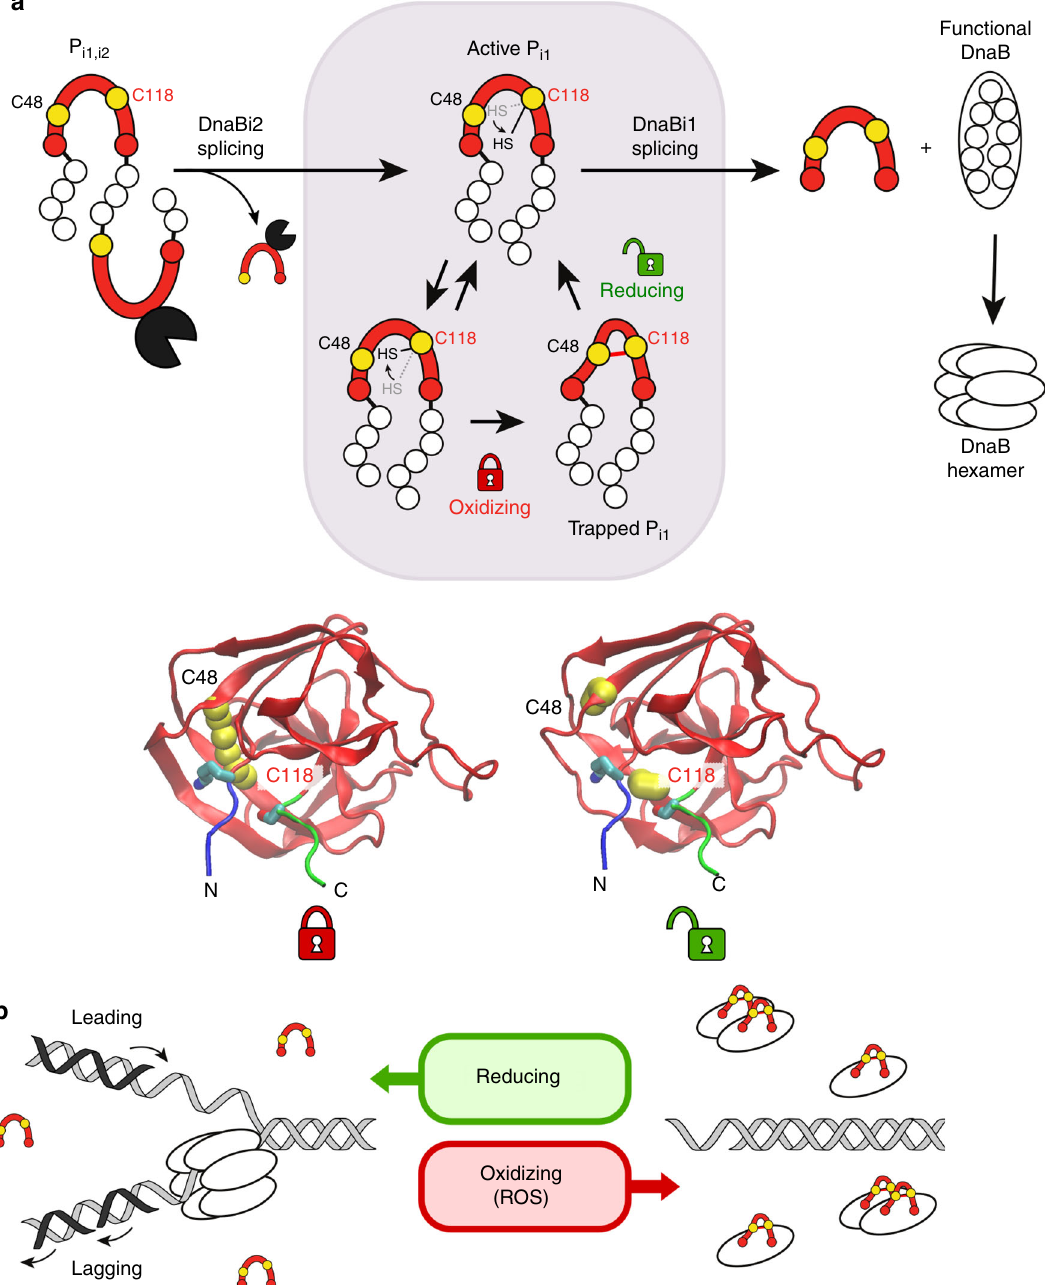
Fig. 7 Model for impact of ROS/RNS stress on DnaB splicing and DNA replication. a Model for DnaBi1 splicing regulation by ROS. The full-length